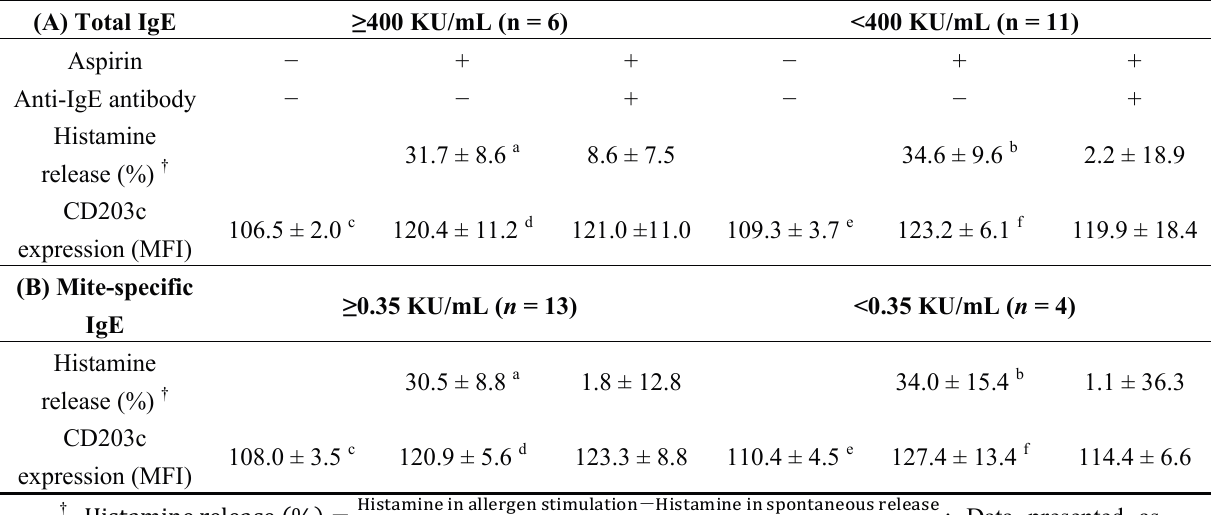
Table 5. Differences in basophil activation activity between the patients with AICU with or without elevation of total ( A ) or mite-specific ( B )